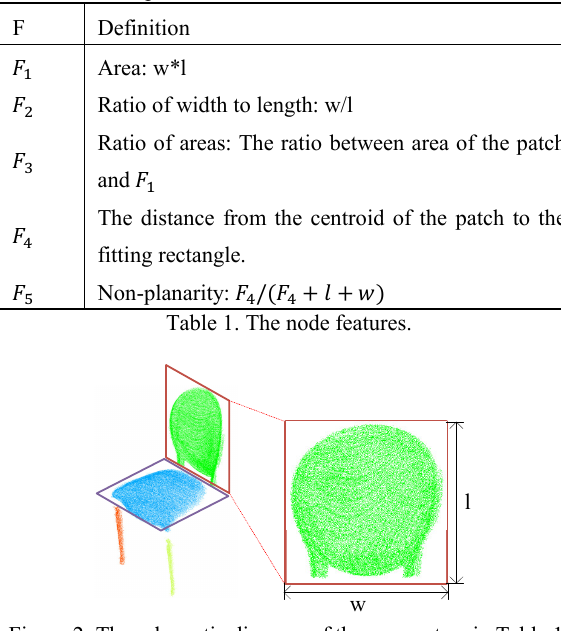
Figure 2. The schematic diagram of the parameters in Table 1. The red box of the patch represents the fitting rectangle, whose length is l and width is w.